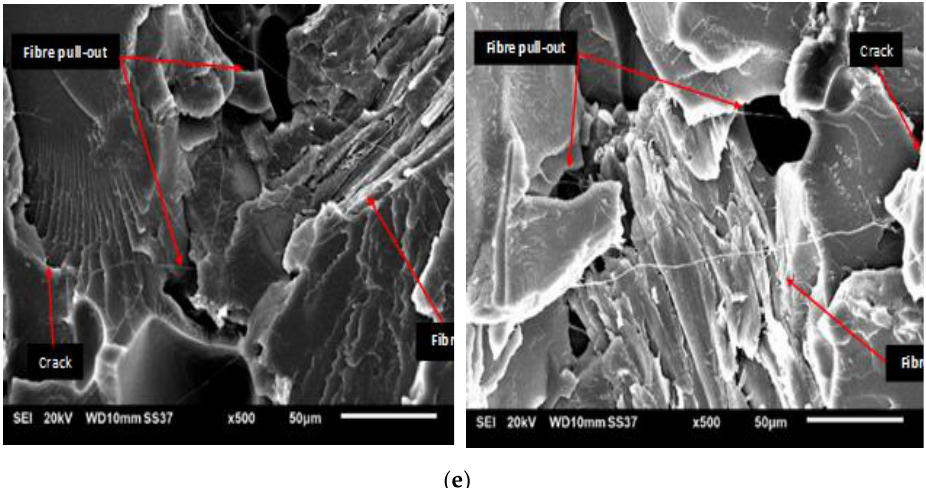
Figure 11. Scanning Electron micrograph ( a ) PLA; ( b ) Untreated fibre; ( c ) 0.5% silane; ( d ) 1.0% silane; ( e ) 2.0% silane.